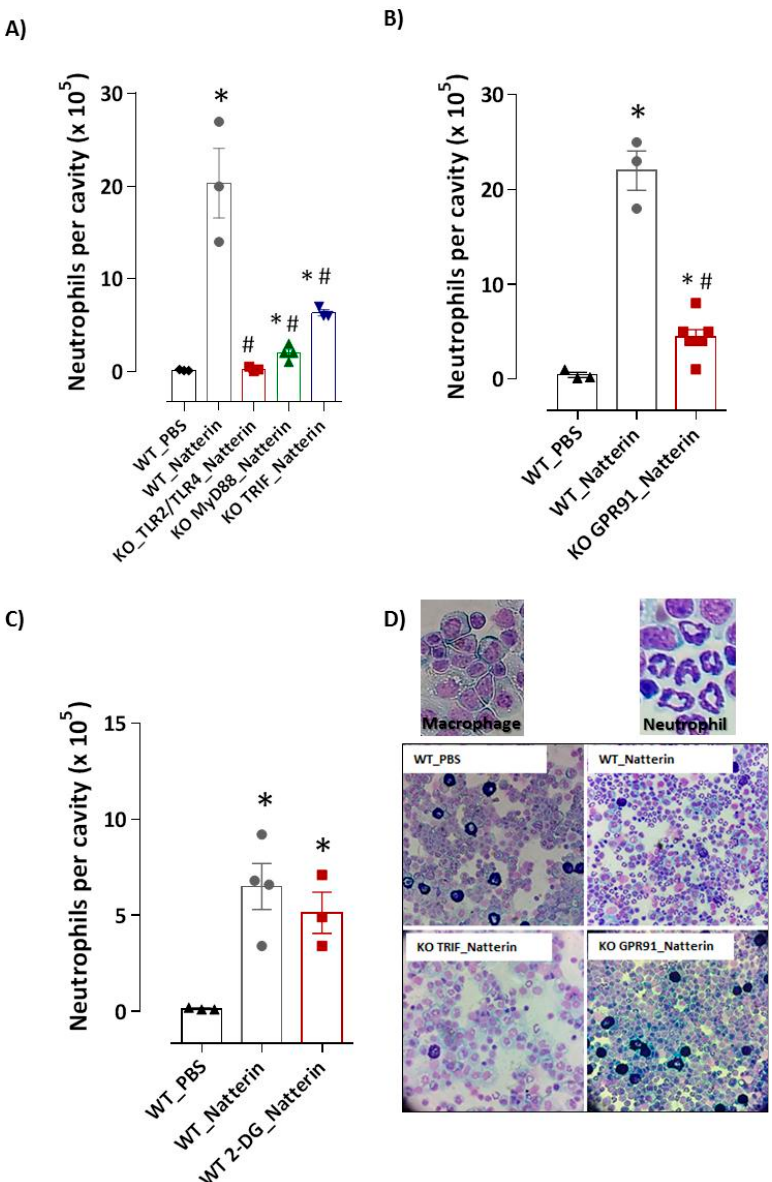
Figure 1. Natterin induces neutrophilic inflammation dependent on PRRs and GPR91 sensors. Natterin (1 μ g diluted in PBS) was injected intraperitoneally (i.p.) in non-treated WT mice ( WT _Natterin) or deficient in tlr2/tlr4 , myd88 or trif ( A ) or gpr91 KO mice ( B ) ( KO _Natterin groups). As a negative control, mice were only injected i.p. with PBS ( WT _PBS). An independent group of WT mice were pre-treated 1 h before Natterin injection with i.p. injection of 2-DG at 10 mg/Kg ( WT 2-DG_Natterin, ( C ). Two hours after injection, mice were killed and the peritoneal cavities were washed to obtain exudates. Peritoneal exudate cells were harvested and the number of macrophages (large leukocytes with a blue-grey ground glass cytoplasm and an irregularly shaped nucleus with vacuoles.) and neutrophils (with 3–5 nuclear lobes and fine granules within the cytoplasm) was evaluated in cytospin slides stained with a Diff-Quick staining kit. Examples of representative photomicrographs are shown in ( D ). Each bar represents the mean ± SEM of 3–5 animals/group. * p < 0.05 compared with WT _PBS group and # p < 0.05 compared with WT